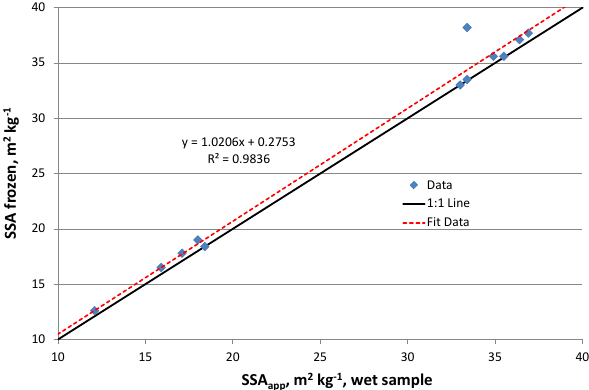
Figure 5. Correlation between the SSAs of the frozen samples, SSA frozen , and the apparent SSA of the wet samples, SSA app . SSA app was determined from reflectance using the algorithm de- veloped for dry